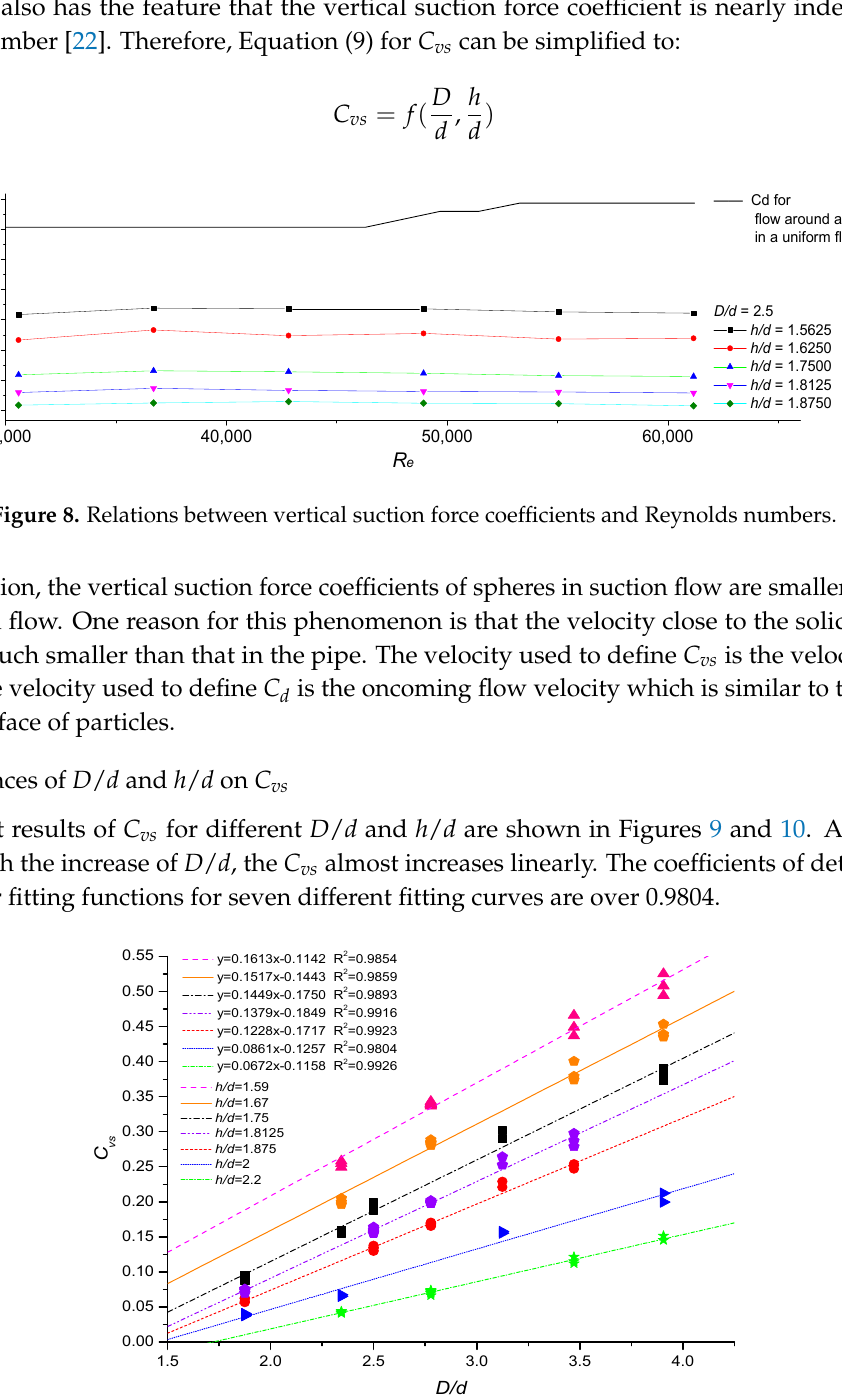
Figure 9. Relations between vertical suction force coefficients and ratios of D to d.